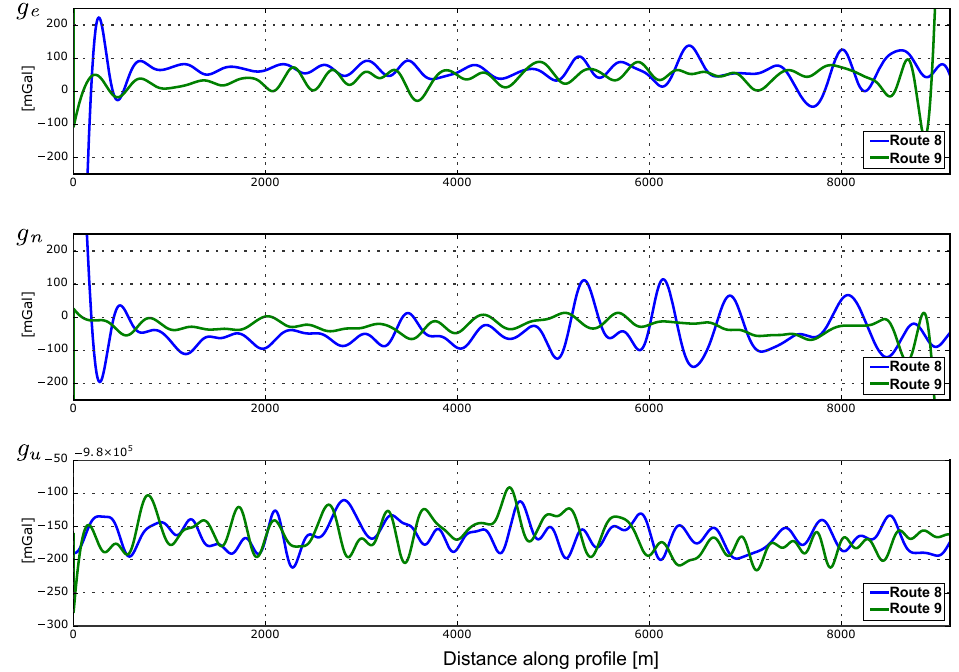
Figure 11. Variations of the gravity vector components g e , g n , g u along the studied profile along route 8 (solid blue curve) and route 9 (solid green curve), calculated according to our UKF-based processing method. The results of route 9 have been reversed to be comparable with the results of route 8.